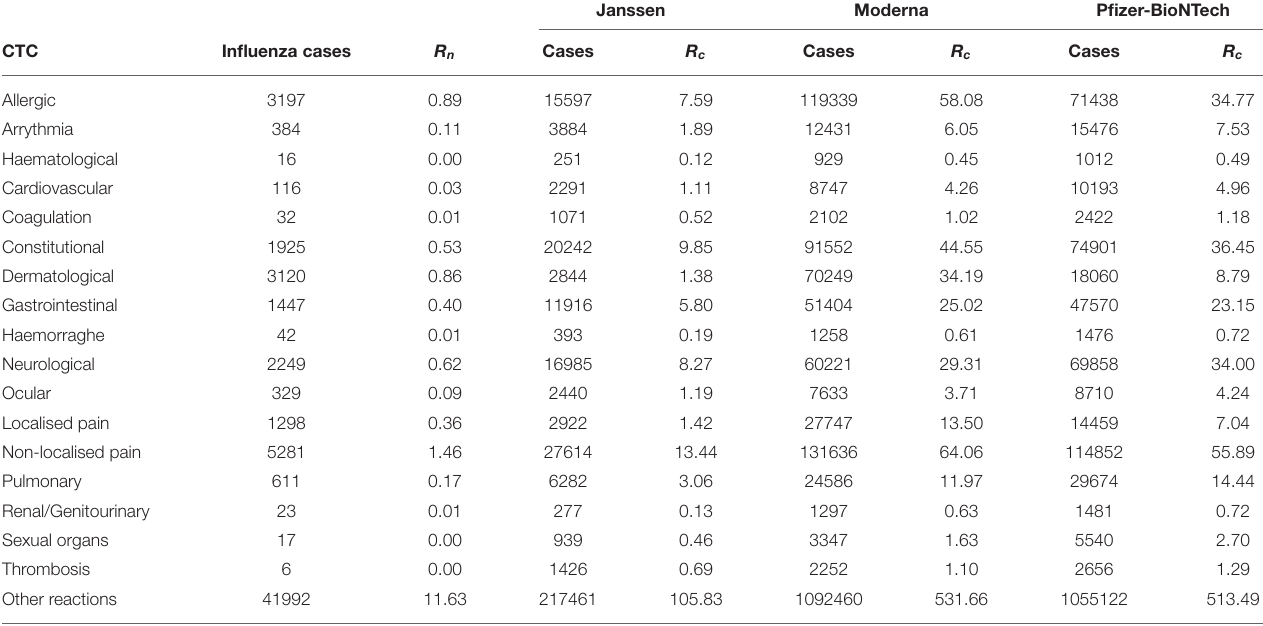
TABLE 3a | Vaccine-related risk estimates of influenza ( R n ) and COVID-19 vaccines ( R c ) per 100,000 exposed individuals by Common Toxicity Criteria (CTC) in the VAERS database.